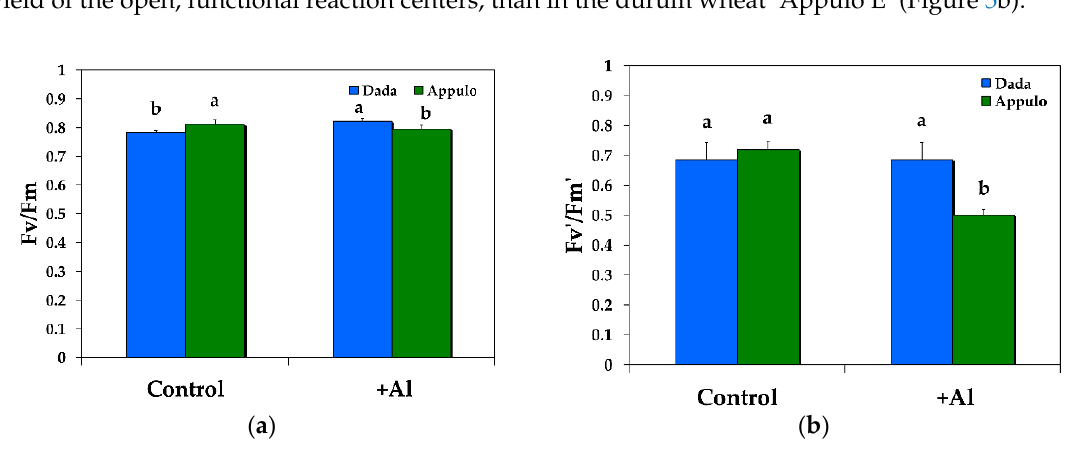
Figure 5. The maximum quantum efficiency of PSII ( F v / F m ) ( a ); and the maximum efficiency of PSII in the light ( F v ’/ F m ’) ( b ); in the triticale ‘Dada’ and the durum wheat ‘Appulo E’, under normal growth conditions (control) and under Al 3+ exposure (+Al). Error bars on columns are standard deviations based on five leaves from five plants. Columns with different letters are statistically different ( p < 0.05).